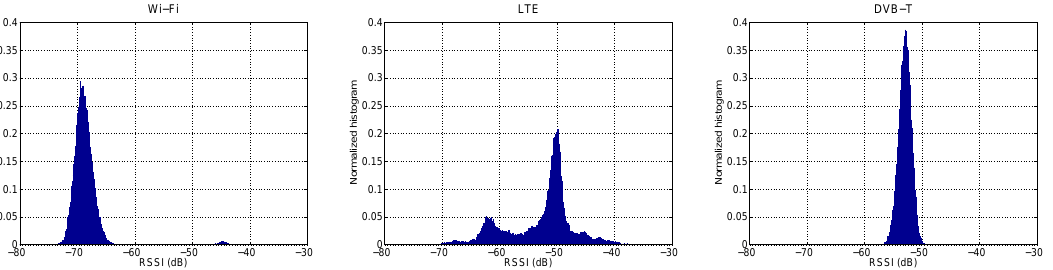
Figure 7. The normalized histograms of RSSI for Wi-Fi, LTE and DVB-T signals obtained by USRPB200 mini with the sample rate of 1